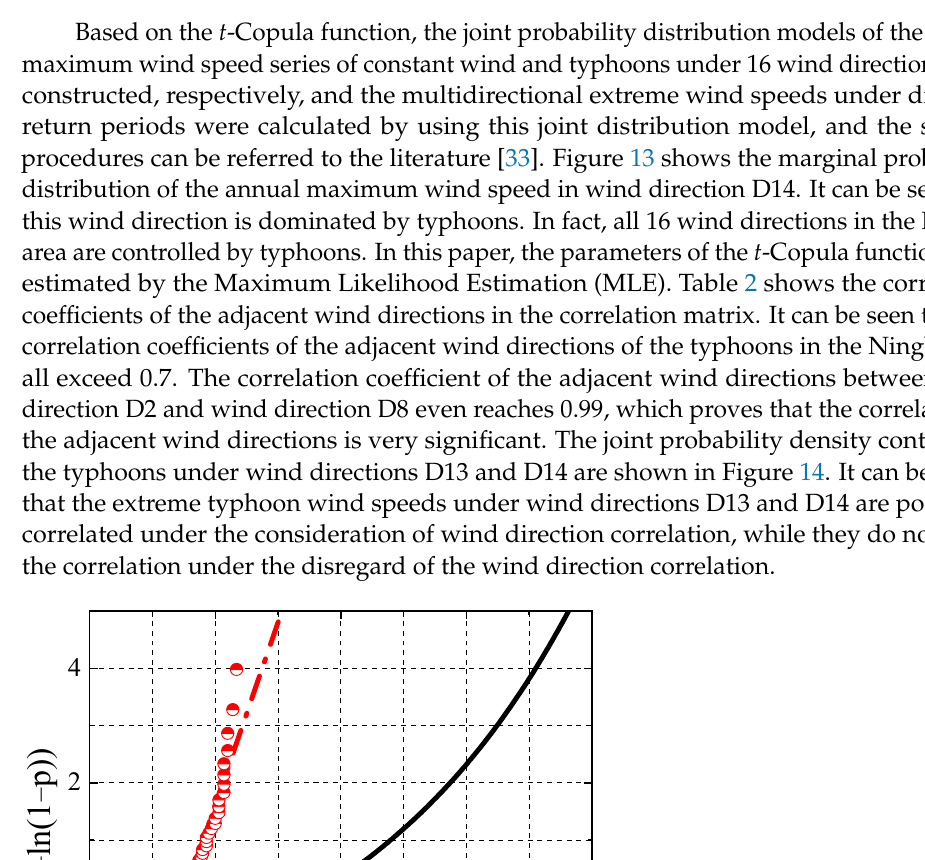
Figure 12. Annual maximum wind speed series of a typhoon in wind direction D14.